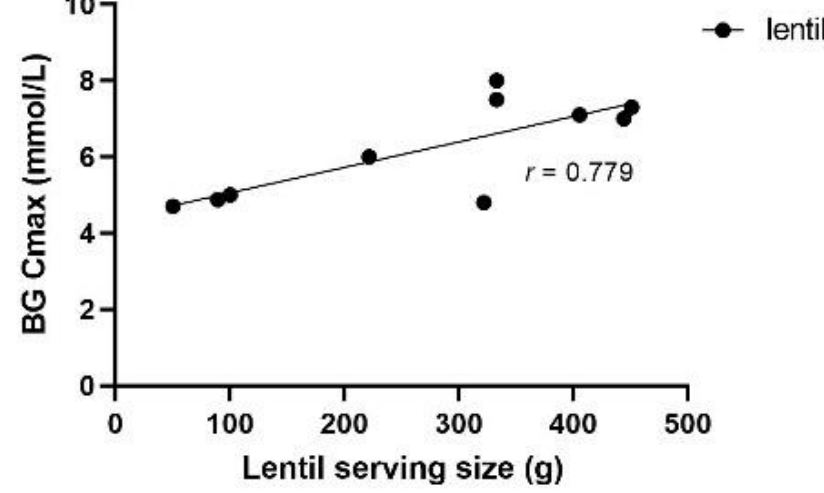
Figure 8. Maximum BG concentration (Cmax, mmol/L) according to lentil serving size (g). The linear trend best represented data ( r = 0.779; n = 10; p < 0.01). The largest serving size investigated (715 g) was removed from this plot.